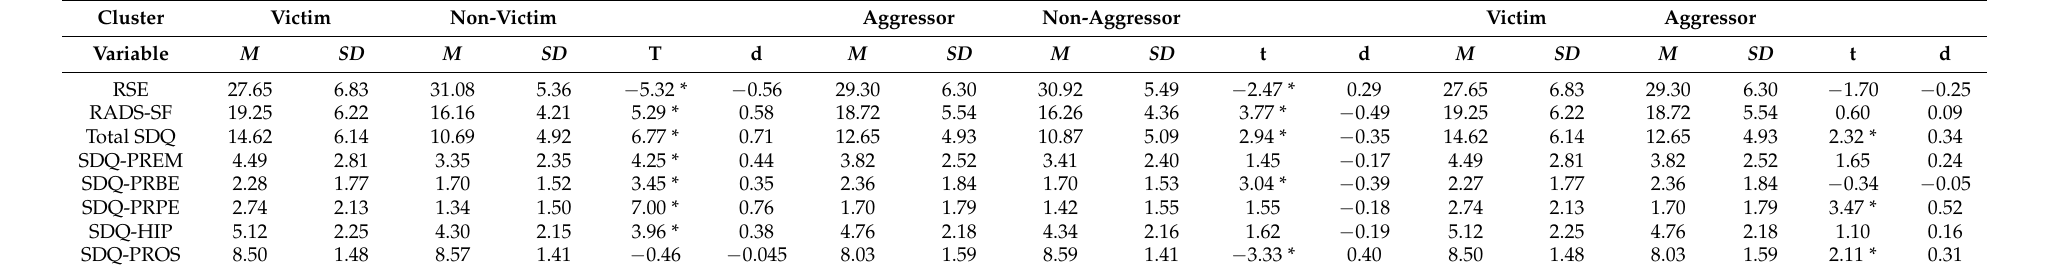
Table 4. Contrasts of means between groups of victims and aggressors of the European Cyberbullying Intervention Project Questionnaire. Cluster Victim Non-Victim